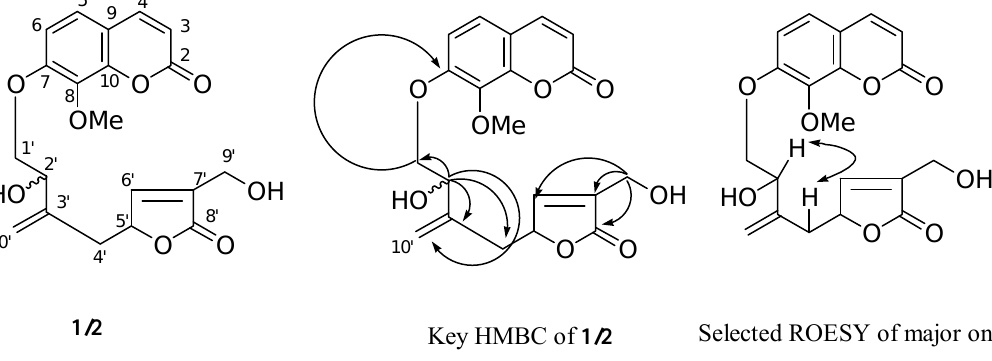
Figure 1. The key HMBC and ROESY correlations of compounds 1 /